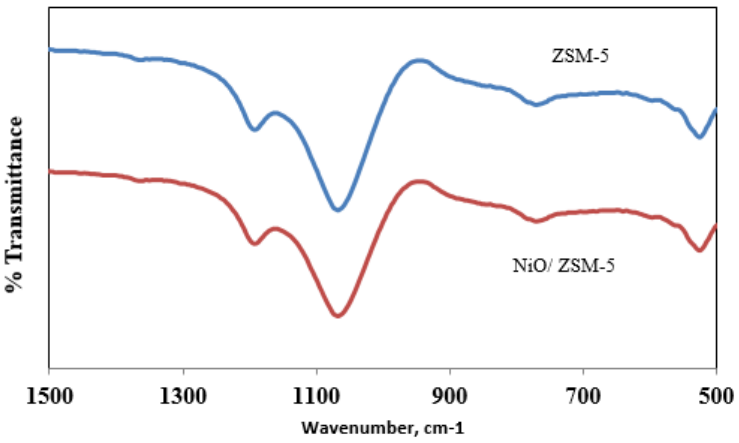
Fig. 3. FTIR pattern of adsorbent. Table 1. Physico-chemical characteristics of crystalline samples